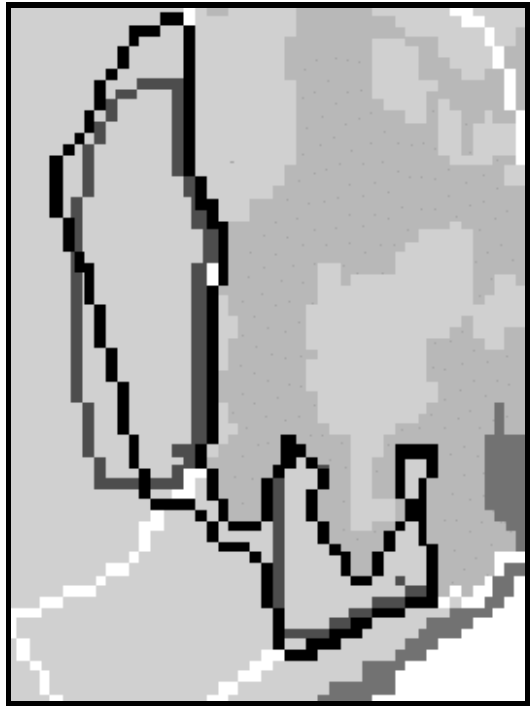
Figure 9. Fire boundaries after 7 hours generated by the simulation model compared with the observed fire boundary for the Trails Camp and Khongolwane areas of MGR. The predicted fire boundary for the Khongolwane area overestimated the degree of spread in the westerly direction by 13%, whereas the rate of spread in the northerly direction was slightly underestimated. In general, the area of the observed and predicted fire boundaries showed favourable agreement with 83% coincidence, 13% overestimation by the simulation model and only 4%